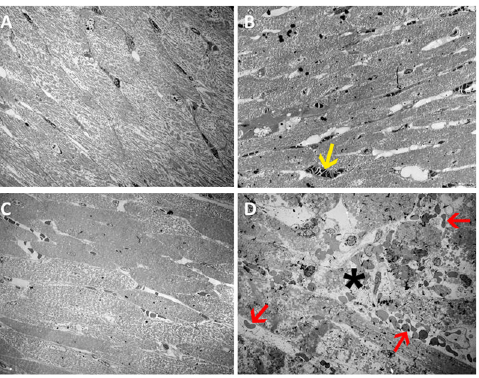
Fig 3. Overview of TEM Images. Transmission electron microscopy images, overview images, magnification 560x. A Images from control samples. B-D Images from infarct zone samples. B 30 – 0 group, C 90 – 0 group, D 30 – 60 group. Massive tissue damage is visible (asterisk), with extravasation of erythrocytes (red arrow), and intraluminal erythrocytes (yellow arrow). White bar represents 10 micrometer.